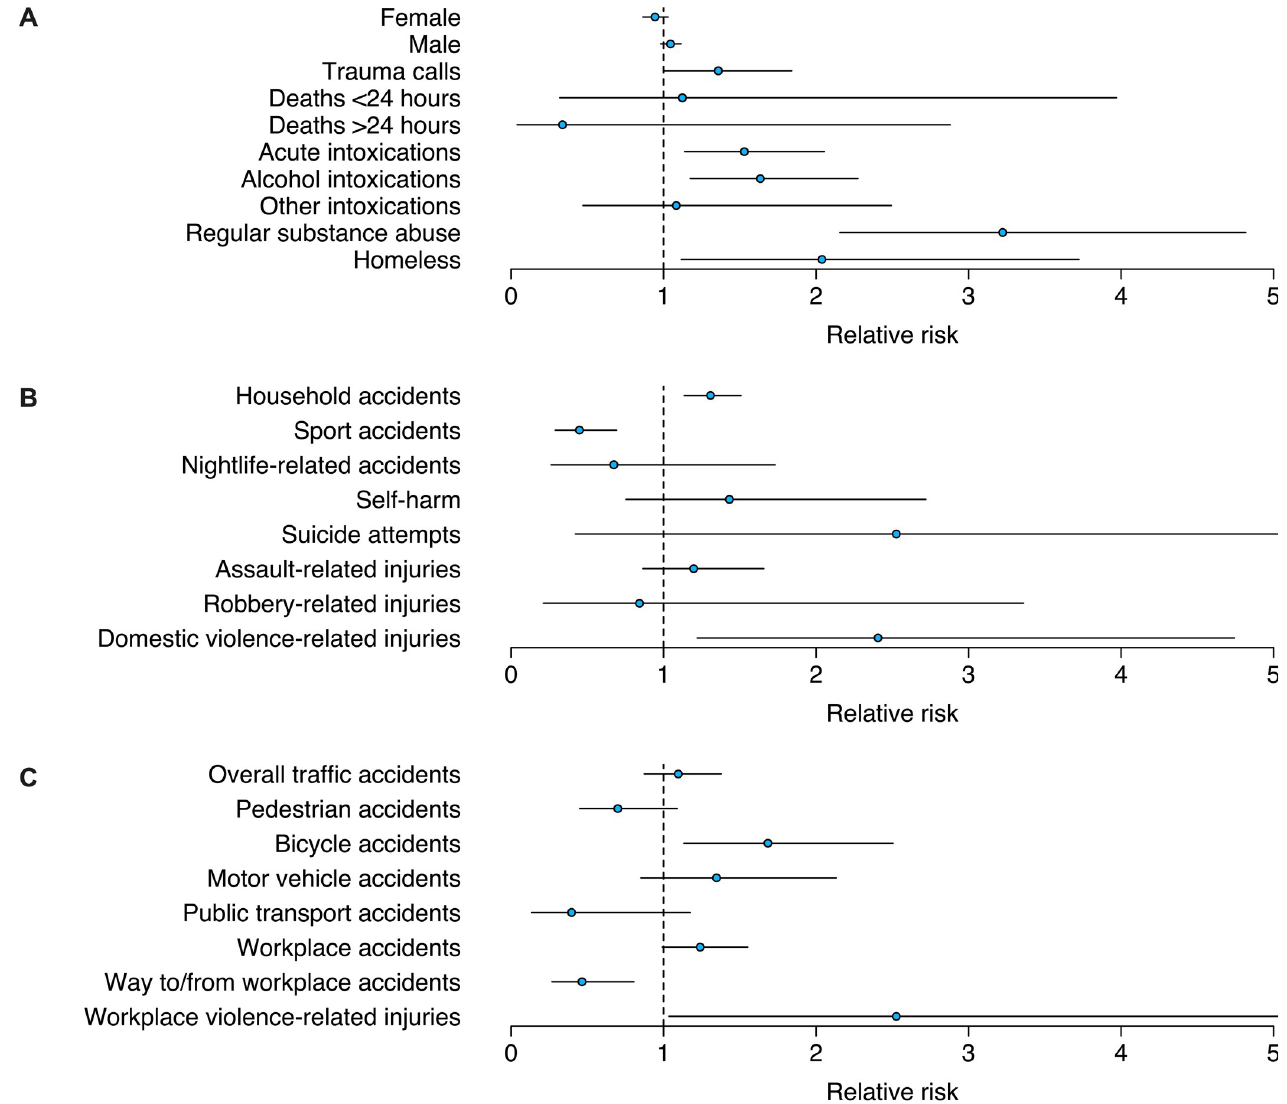
Fig 3. Plots showing RRs during the SHUTDOWN compared to the CTRL period for selected outcomes. (A) Demographic specifics, trauma calls, deaths and substance abuse, (B) trauma causes within private environments and (C) within traffic and workplace environments. Circles indicate RRs (SHUTDOWN vs. CTRL) and whiskers the 95%